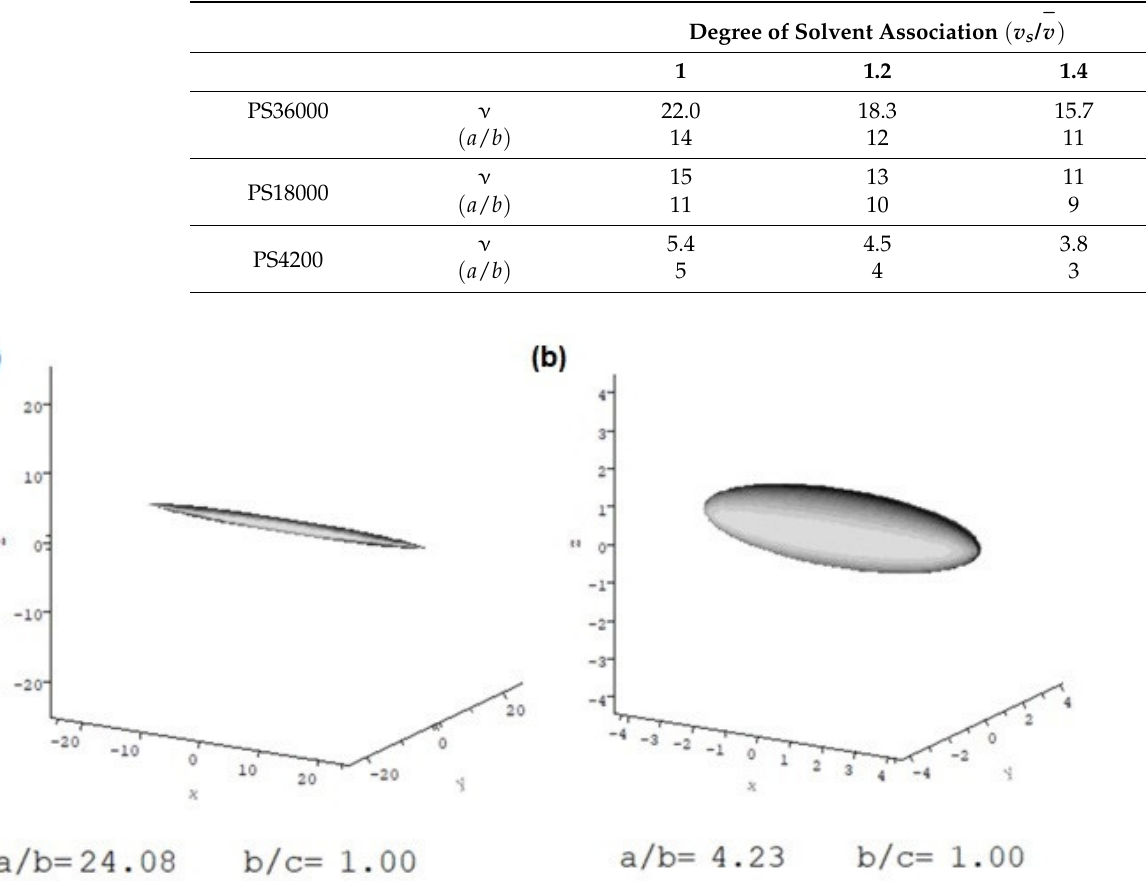
Figure 9. Conformation in isopropanol (equivalent hydrodynamic ellipsoids) for ν at ( v s / v ) = 1.2 us- ing the programme ELLIPS1 of ( a ) Butvar B-98 in isopropanol; ( b ) PS36000 siloxane in isopropanol. ELLIPS1 representations of PS18000, PS4200, and PS550, as well as polymers in turpentine, are shown in Supplementary Figure S1.